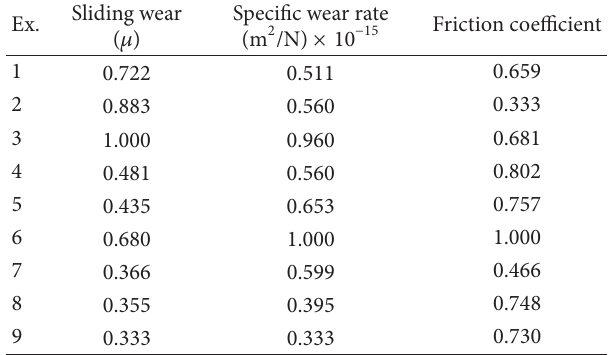
T 6: Grey relational coefficient of each performance character- istic.